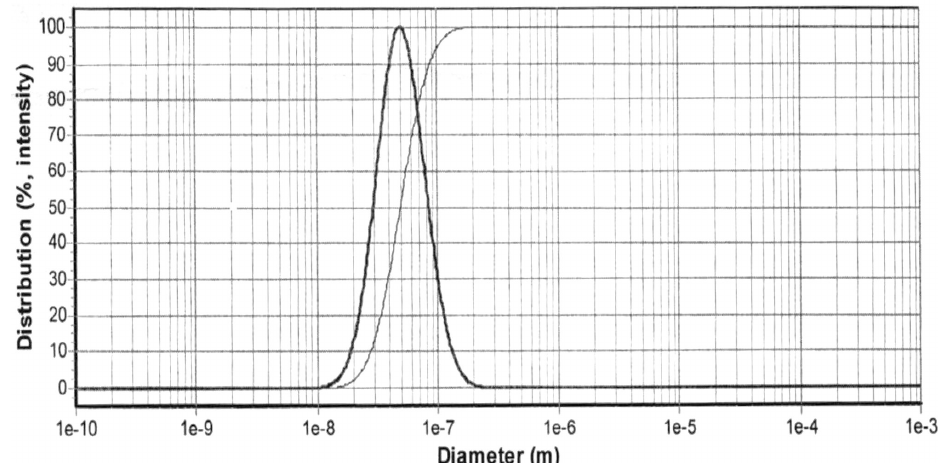
FIGURE 1 - Particle size distribution of ampicillin solid lipid nanoparticles after freeze-drying using 5% mannitol as